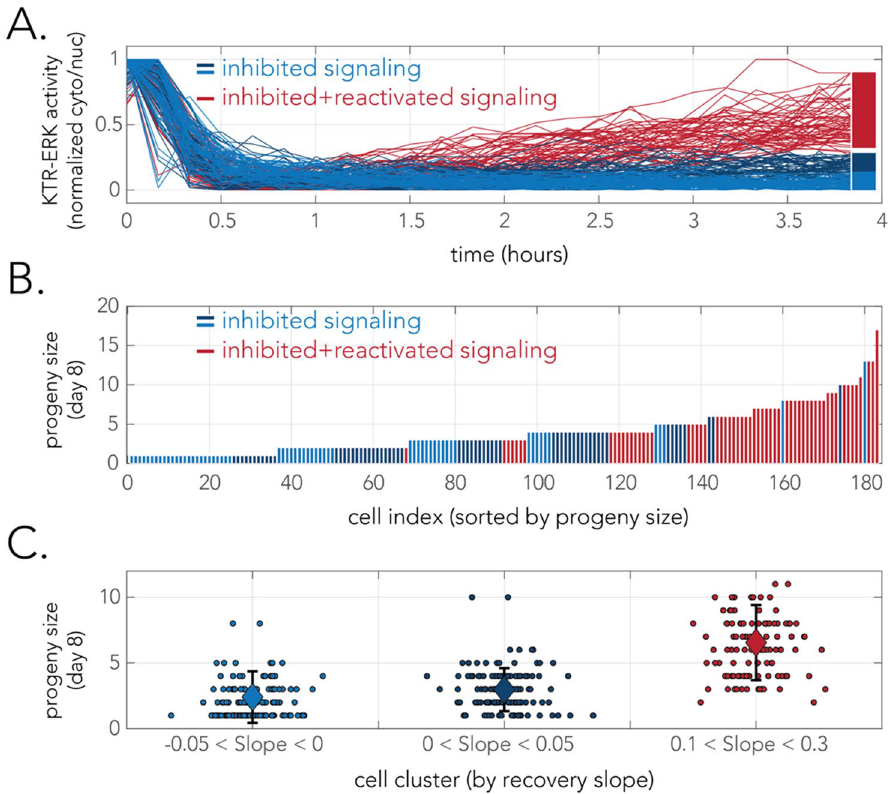
Figure 4. Single-cell measurements connect early signaling recovery with long term drug resistance. ( A ) Signaling dynamics at the first 4 h after drug treatment of 180 cells treated with inhibitory concentration of vemurafenib (6 uM). The colors mark the signaling recovery capacity of the cells (recovering cells in red and non-recovering cells in blue). The identity of the cells was determined solely according to the slope of the signaling curve after the initial inhibition phase. The non-recovering cells were further subdivided to strongly inhibited cells (light blue) and weakly inhibited cells (light blue). ( B ) Lineage sizes descending from the 180 cells after seven days of drug treatment. The bars show the lineage descending from single cells and the bar colors mark initial signaling recovery of the ancestor cell. ( C ) Lineage sizes descending from ancestor cells according to the signaling recovery group. Each point marks the lineage descending from a single ancestor cell and the large diamond markers show the average lineage size. Error bars represent standard